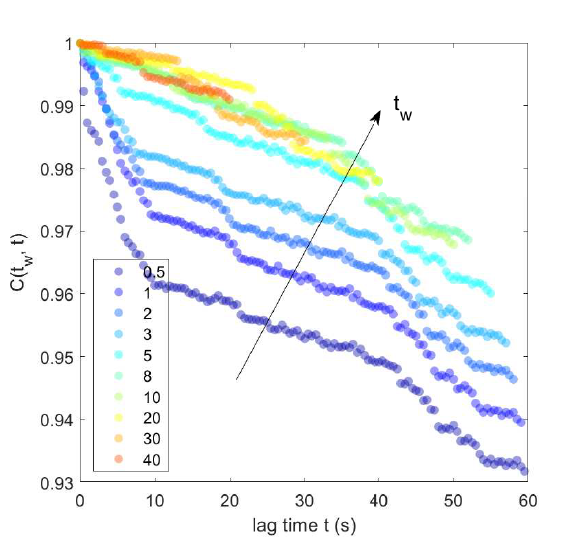
Figure 3. Time correlation function of σ for di ff erent waiting times, from 0.5 to 40 seconds, as indicated in the legend. Figure adapted from